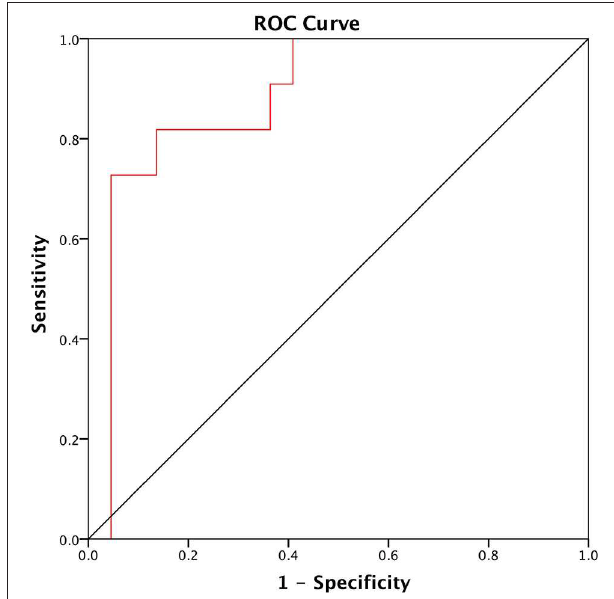
FIGURE 1 | ROC of the Pediatric NAFLD Fibrosis Score (PNFS) to distinguish between NAFLD patients with and without fibrosis. The area under the ROC curve (AUROC) is 0.884 (95% CI: 0.763, 1.00; p <